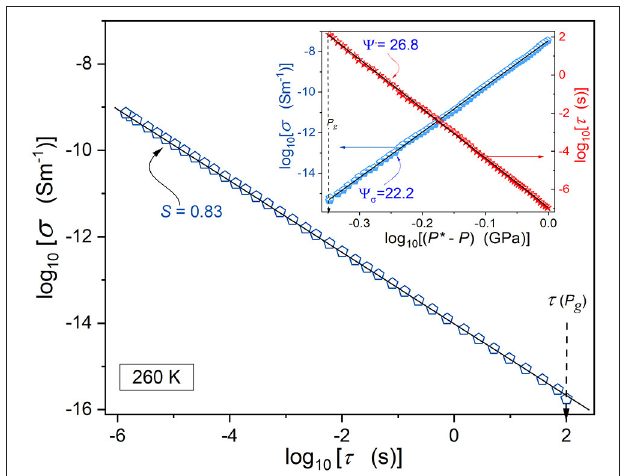
FIGURE 5 | The pressure evolution of the primary relaxation time and electric conductivity for superpressed 8 * OCB ( T = 260K isotherm), based on a log-log scale plot [see Equations (20, 21)]. The main part of the plot shows the f- DSE behavior in the high-pressure dynamical domain [see Equation (19)].